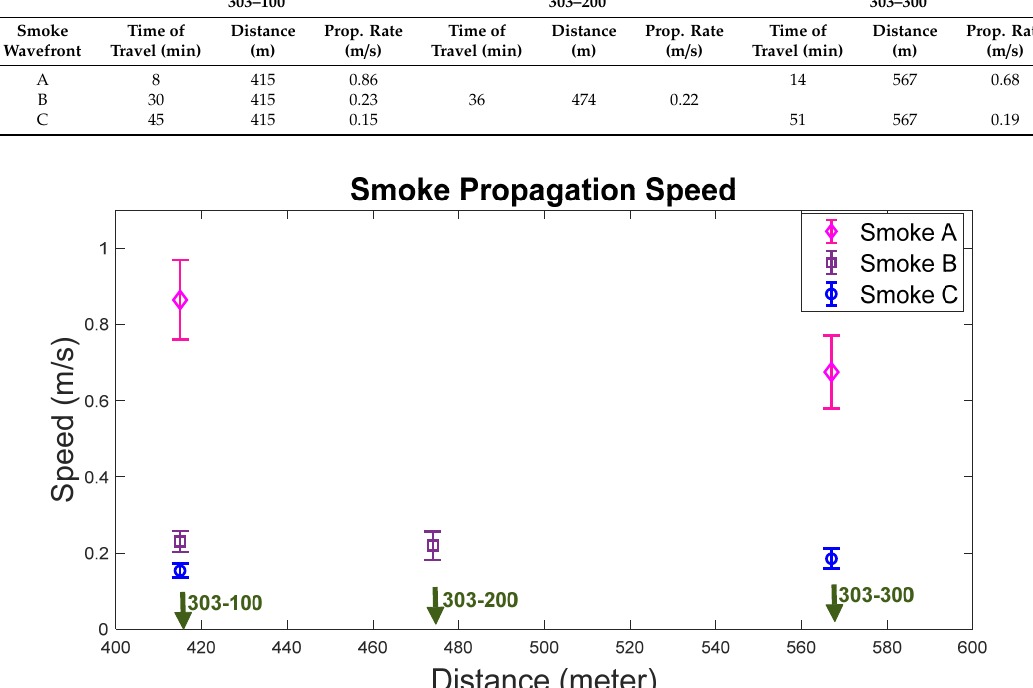
Figure 9. Smoke propagation speed at sensor locations versus distances. Distances of sensor locations at north ( µ S303–100), northwest ( µ S303–200), and northeast ( µ S303–300) are marked in the figure. Uncertainties in propagation speed estimates are shown by error bars.